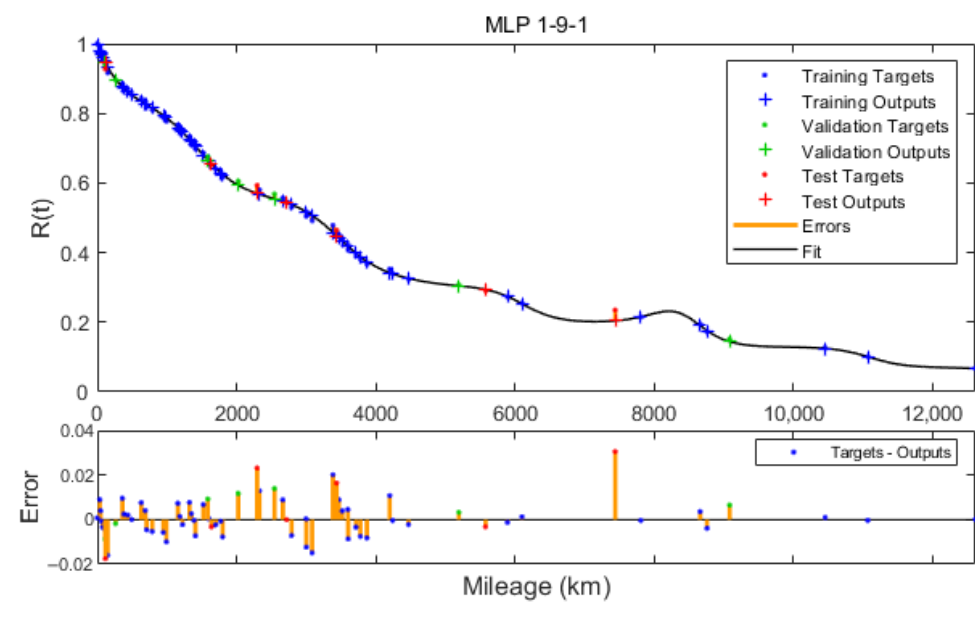
Figure A8. Reliability function approximated by MLP 1-9-1.